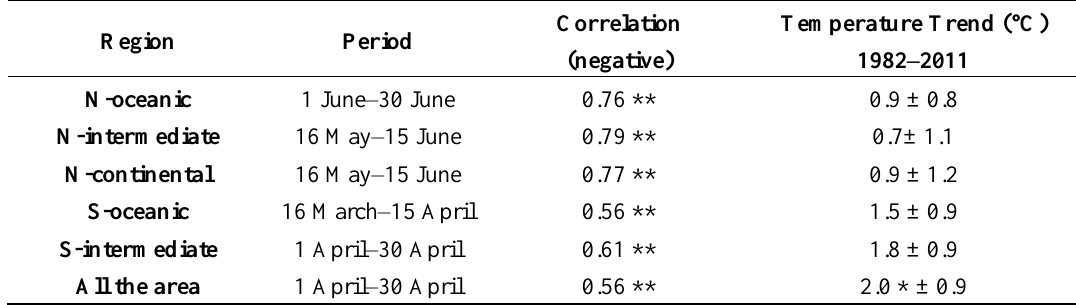
Table 2. Four-week period with the highest correlation to the start of the growing season, correlation and temperature trend. * p < 0.05; ** p <